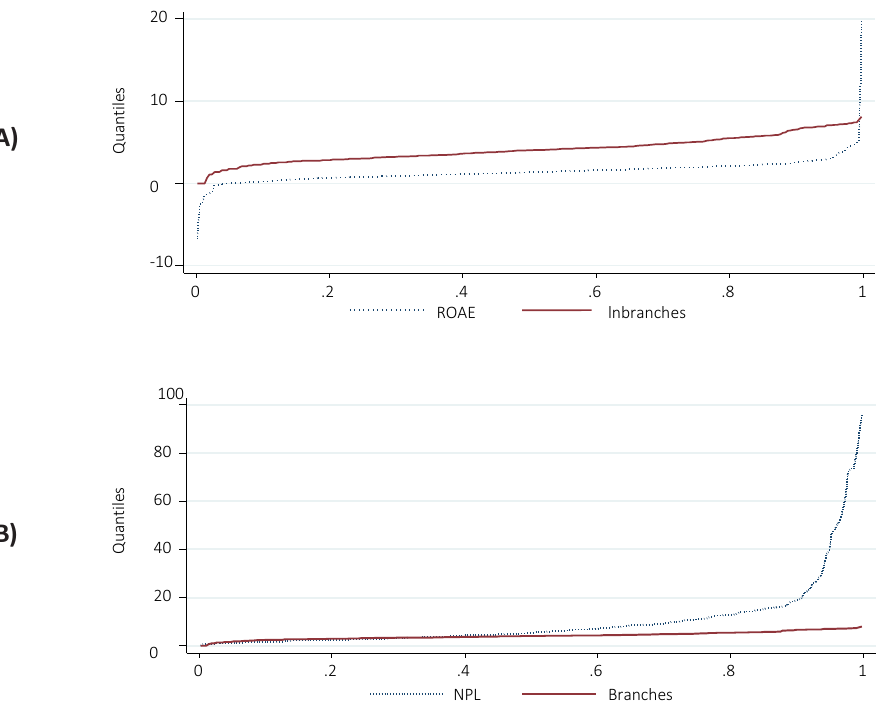
Figure 1. Quantile regression